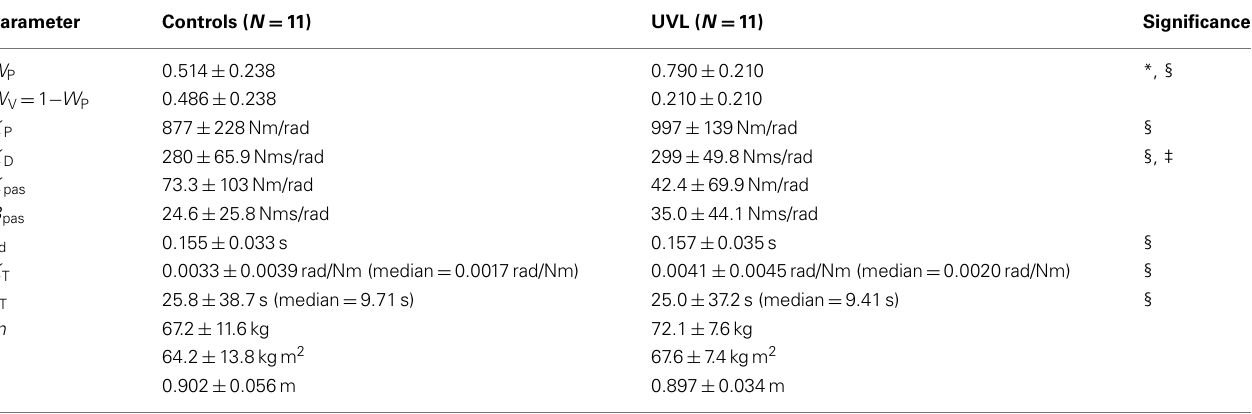
Table 3 | Model parameters (mean ±